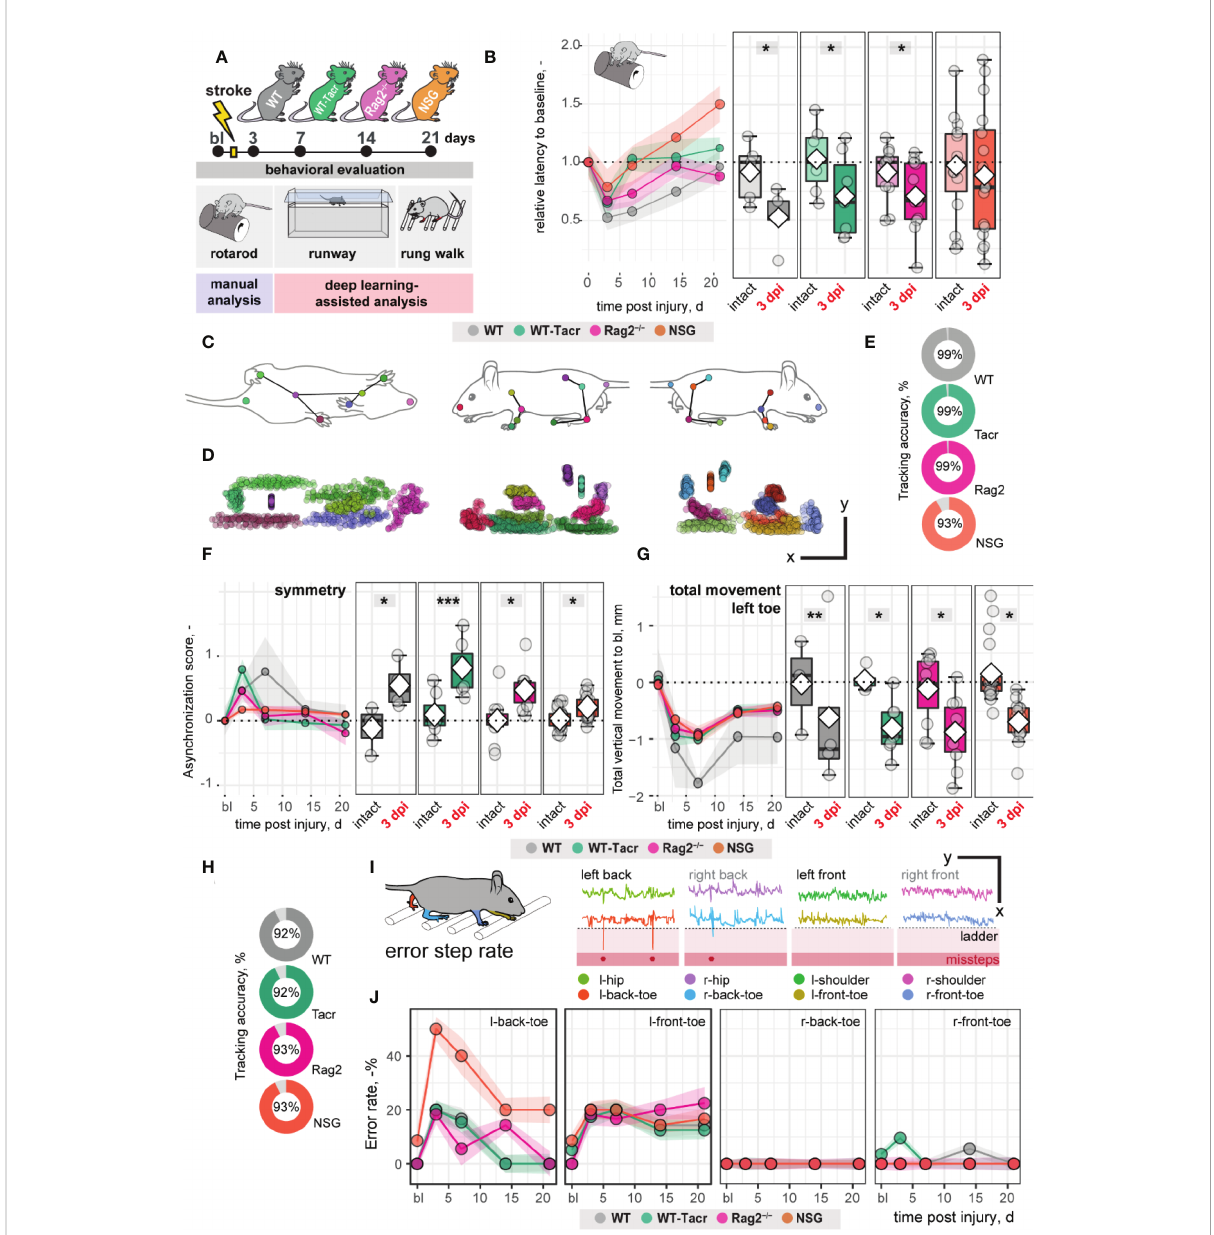
FIGURE 3 Gait and motor performance of immunosuppressed mice after stroke. (A) Schematic time course of experimental interventions. (B) Rotarod test showing the relative latency at baseline and 3, 7, 14, 21 dpi. (C, D) Walking pro fi le normalized to the hip coordinates of randomly selected non- injured mice. Each dot represents an anatomical landmark. (E) Likelihood of a con fi dent labelling for individual body parts in the runway. (F) Ratio of asynchronization at baseline, 3, 7, 14, 21 dpi. (0 = ideal synchronization). (G) Absolute vertical movement of left (contralesional) toe at baseline and 3, 7, 14, 21 dpi. (H) Likelihood of a con fi dent labelling for individual body parts in the ladder rung test (I) Representation of an individual ladder rung walk of WT mice at 3 dpi, selected body parts are tracked including hip, back toe, shoulder, and front toe. (J) Time course of error rate during ladder rung test in the individual paws. Data are shown as mean distributions where the white dot represents the mean. Boxplots indicate the 25% to 75% quartiles of the data. For boxplots: each dot in the plots represents one animal. Line graphs are plotted as mean ± sem. For line graphs: the dots represent the mean of the data. Signi fi cance of mean differences between the groups was assessed using repeated ANOVA with post-hoc (emmeans) analysis. Asterisks indicate signi fi cance: *P < 0.05, **P < 0.01, ***P <